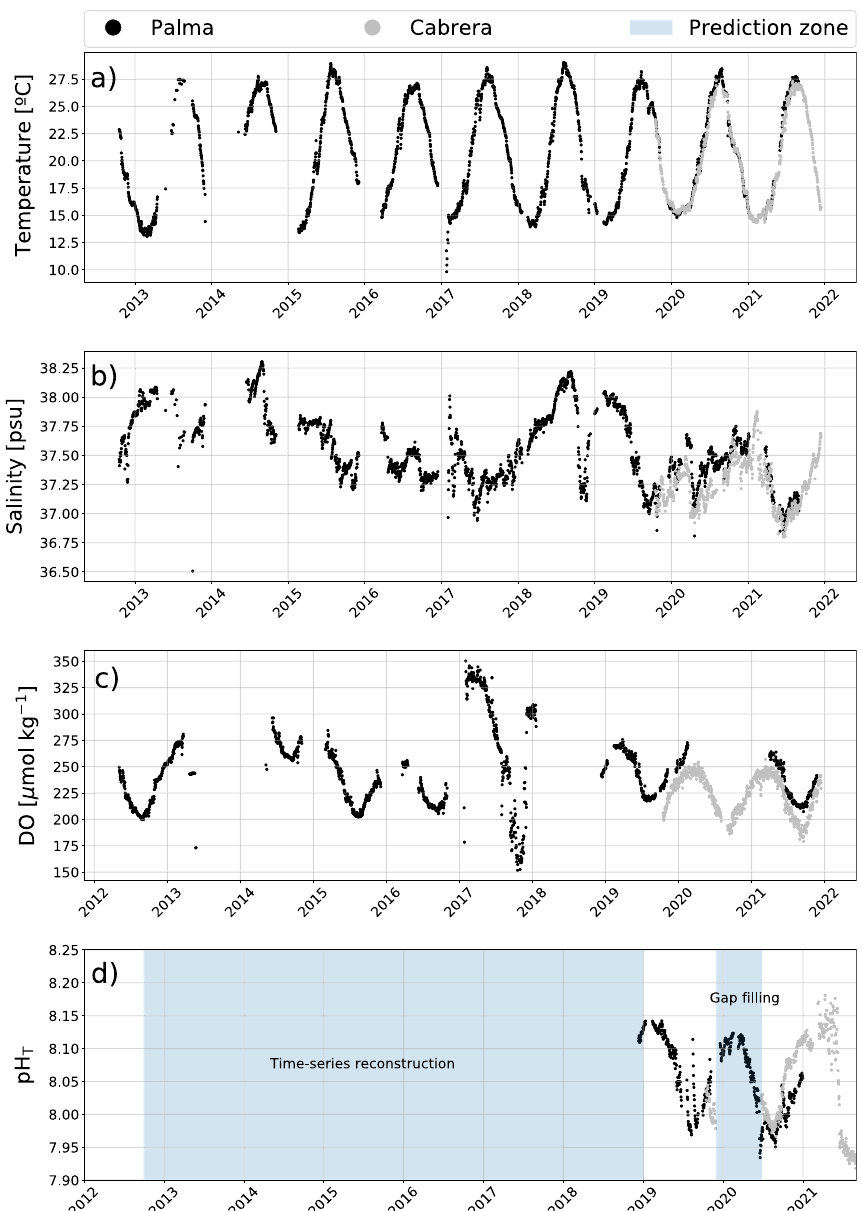
Figure 1. Daily averaged time series data from the Bay of Palma (black dots) and Cabrera stations (grey dots): ◦ ( a ) temperature ( C), ( b ) salinity (psu), ( c ) dissolved oxygen (DO) ( µ mol kg pH time series of the Bay of Palma will be reconstructed in the period 2012–2021 while only gaps will be filled in Cabrera, as marked in blue in the